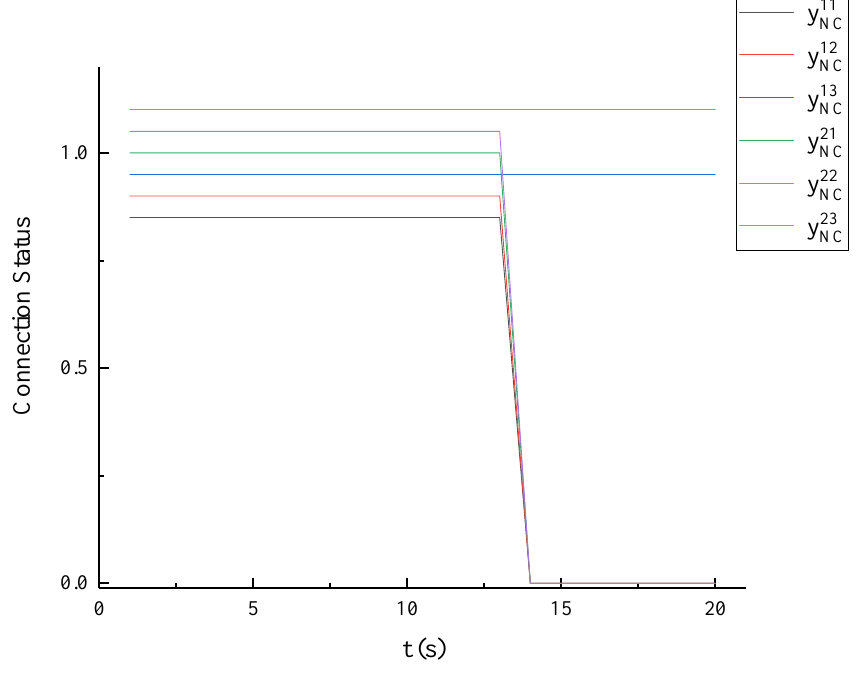
Figure 10. Non-critical loads connection status. Table 3. Comparison of the performance of the proposed method with DQN + DDPG, DDPG and